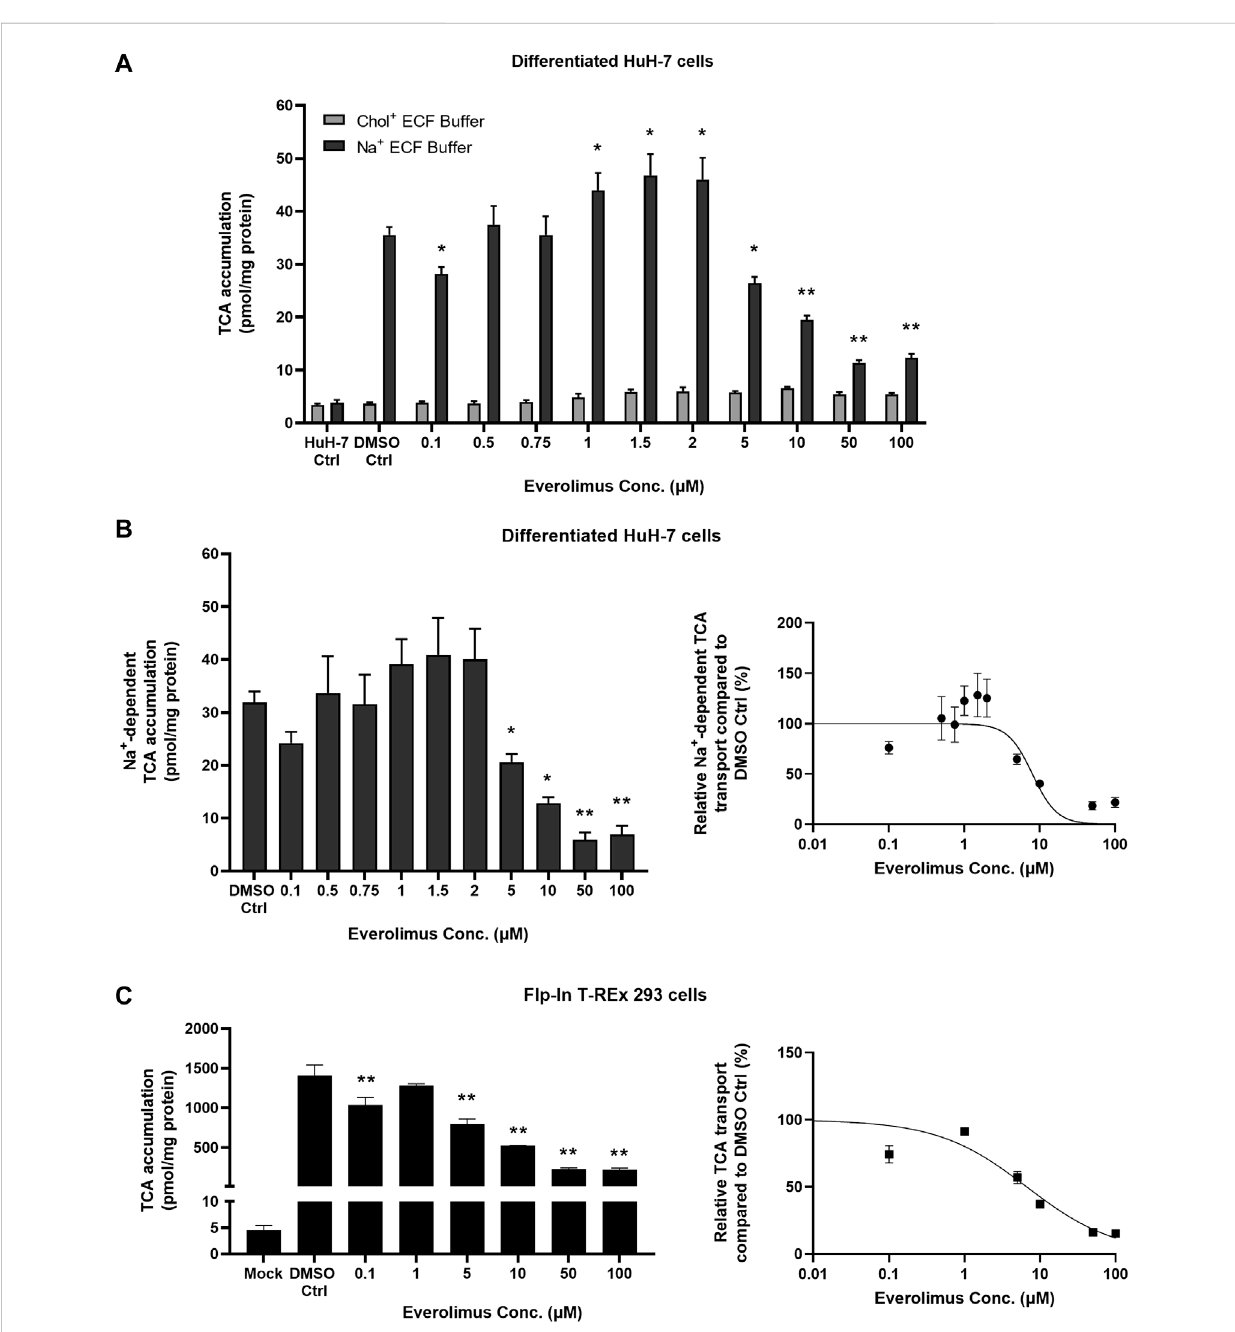
Concentration-dependent inhibition of NTCP-mediated taurocholate (TCA) transport by everolimus. Accumulation of [ 3 H]-TCA (2 μ M; 200 nCi/ mL) in extracellular fl uid buffer (ECF) with Na + over 10 min in the absence (DMSO Ctrl; 0.1%) and presence of everolimus (0.1 – 100 µM) was measured in (A) undifferentiated HuH-7 cells (HuH-7 Ctrl) and differentiated HuH-7 cells. Data were plotted as mean ± SD ( n = 3). Statistically signi fi cant differences compared to DMSOCtrlweremeasured usinganordinarytwo-wayANOVAwith Dunnett ’ smultiplecomparisontest(*, p < 0.05, **, p < 0.0001). (B) Left panel: Na + -dependent[ 3 H]-TCA accumulation was calculated bysubtracting [ 3 H]-TCAaccumulation inChol + bufferfrom [ 3 H]-TCA accumulation in Na + buffer. Right panel: Relative Na + -dependent [ 3 H]-TCA transport was plotted with respect to everolimus concentration as a non-linear regression to calculate best fi t IC 50 of 8.0 ± 1.3 µM. (C) Left panel: Mock-GFP or NTCP-GFP were induced in Flp-In ™ T-REx ™ 293 cells with 1 μ g/mL doxycycline for three days. Accumulation of [ 3 H]-TCA (2 μ M; 200 nCi/mL) in ECF with Na + over 10 min in the absence (DMSO Ctrl; 0.1%) and presence of everolimus (0.1 – 100 µM) was measured in stably transfected Mock-GFP and NTCP-GFP-expressing Flp-In ™ T-REx ™ 293 cells. Right panel: Relative [ 3 H]-TCA transportwasplottedwithrespecttoeverolimusconcentrationasanon-linearregressiontocalculatebest fi tIC 50 of6.7±1.3 µM.Alldatawereplottedas mean±SD( n =3).ErrorbarsarenotvisiblewhentheSDissmallerthanthedatapoint. (B) and (C) Leftpanels:Statisticallysigni fi cantdifferencescompared to DMSO Ctrl were measured using an ordinary one-way ANOVA with Dunnett's multiple comparison test (*, p < 0.05, **, p <